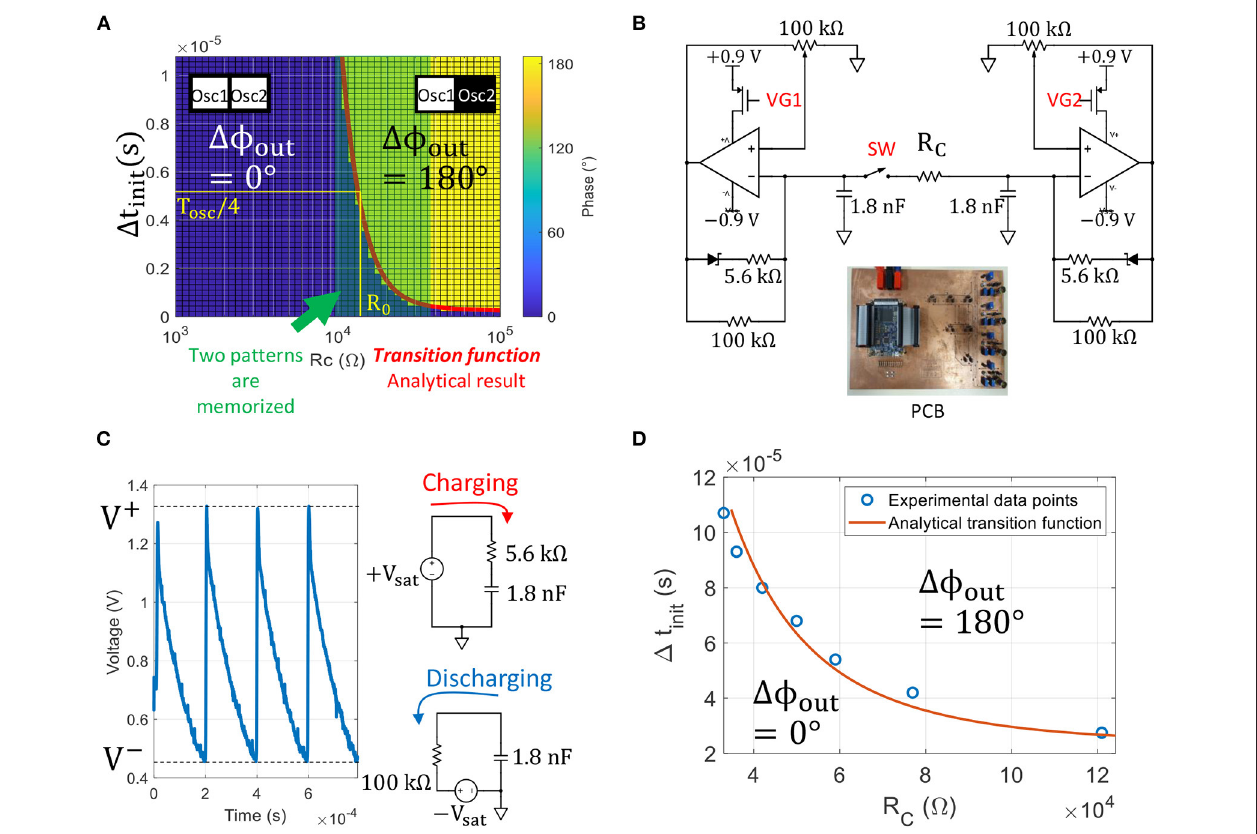
FIGURE 5 | (A) Plot showing the phase relation between two oscillators for every set of parameters ( R C , 1 t init ). As expected, small coupling resistances tend to pull the oscillator phase together, whereas large coupling resistances push the phase away. The green region shows the coupling resistance range 10k (cid:127) < R C < 40k (cid:127) in which two patterns (0 ◦ and 0 ◦ ) and (0 ◦ and 180 ◦ ) are memorized and can be retrieved by adjusting the input delay. The red curve is our analytical model describing the transition between the two phase states in the plan ( R C , 1 t init ), and plays a major role in the ONN ability to memorize patterns. (B) Experimental set-up of two coupled relaxation oscillators based on MCP6001 OPAs. We delay VG2 with respect to VG1 by 1 t init to set the initial phase, and we close SW after initialization. (C) Experimental oscillating waveform and equivalent circuits during charge and discharge of the output capacitor. (D) Experimental phase transition curve and analytical model in plain